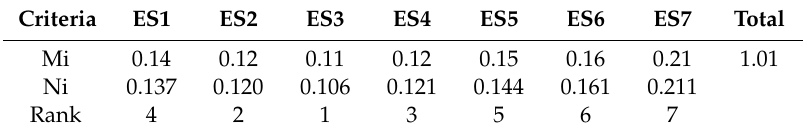
Table 8. The average, normalized weight, and rank of criteria for environmental sustainability.